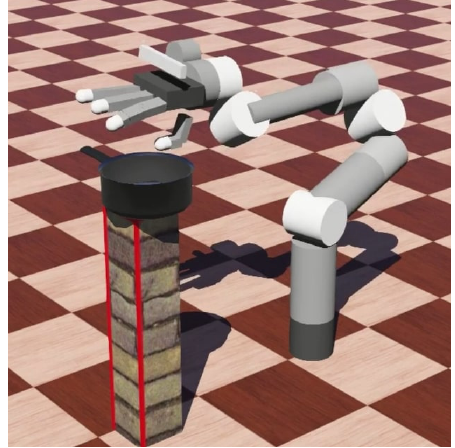
Figure 14. Simulated